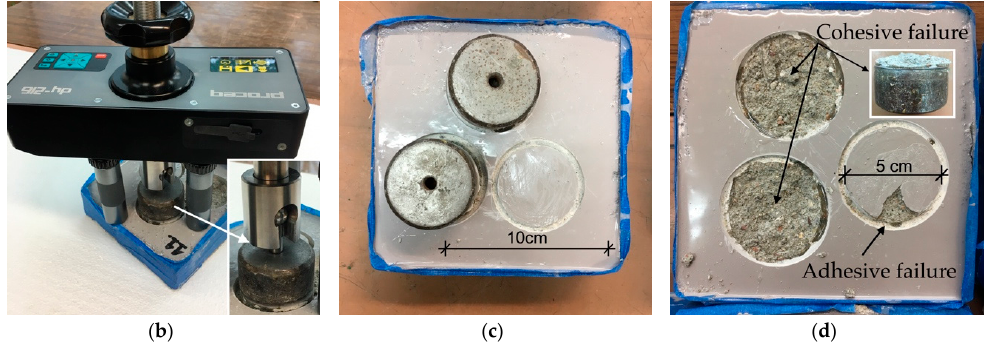
Figure 8. Pull-off method: ( a ) scheme of the pull-off strength test; ( b ) Proceq dy-216 measuring the pull-off strength; ( c ) view of the discs glued to the coating; ( d ) cohesive and adhesive failure.